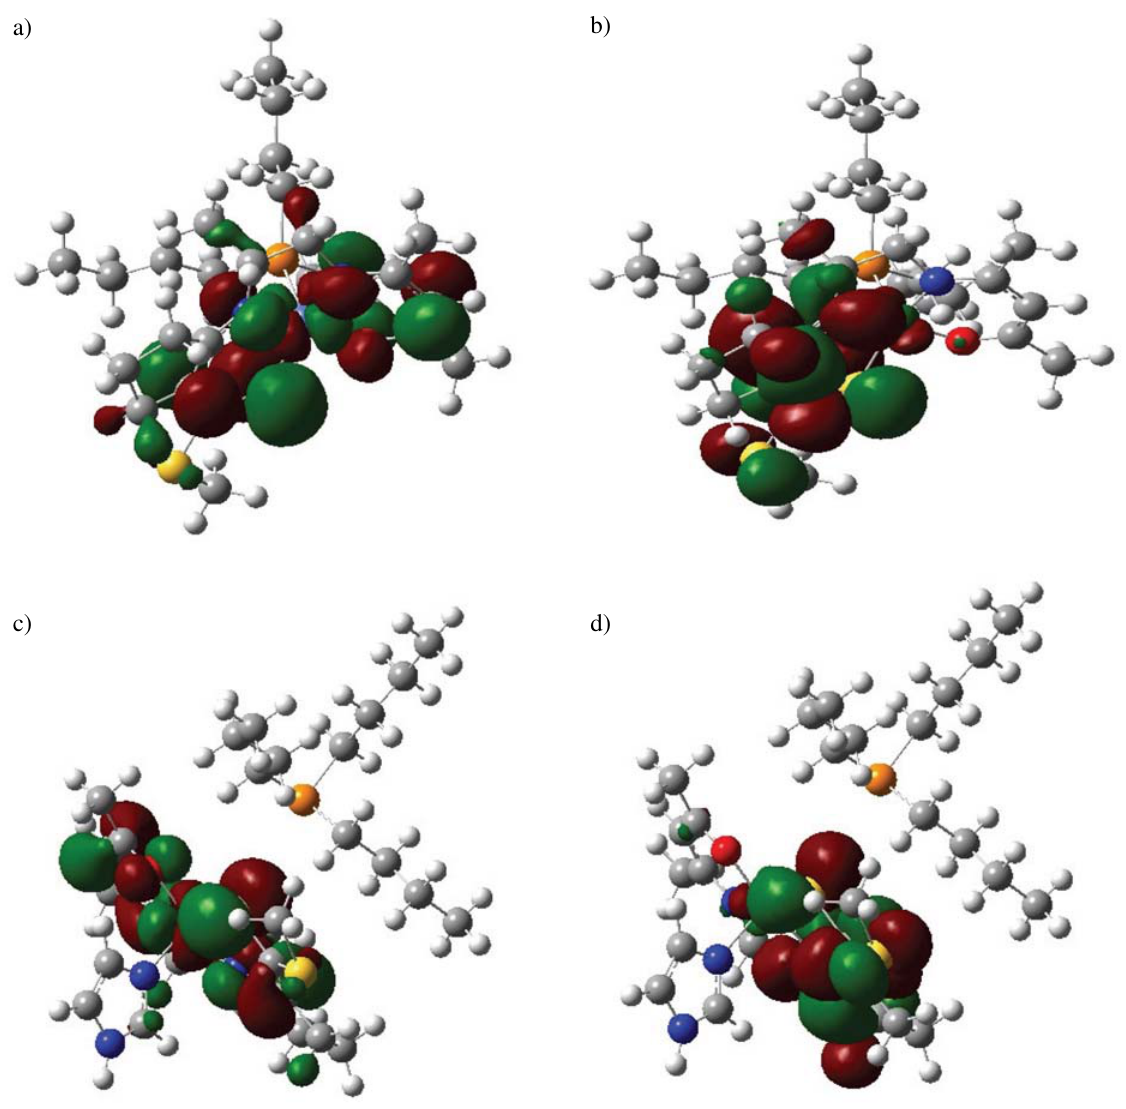
Figure 5. Molecular orbital surfaces for the HOMO and LUMO of the [ Co(cdacacen)(PBu ted at B3LYP/6-311G**